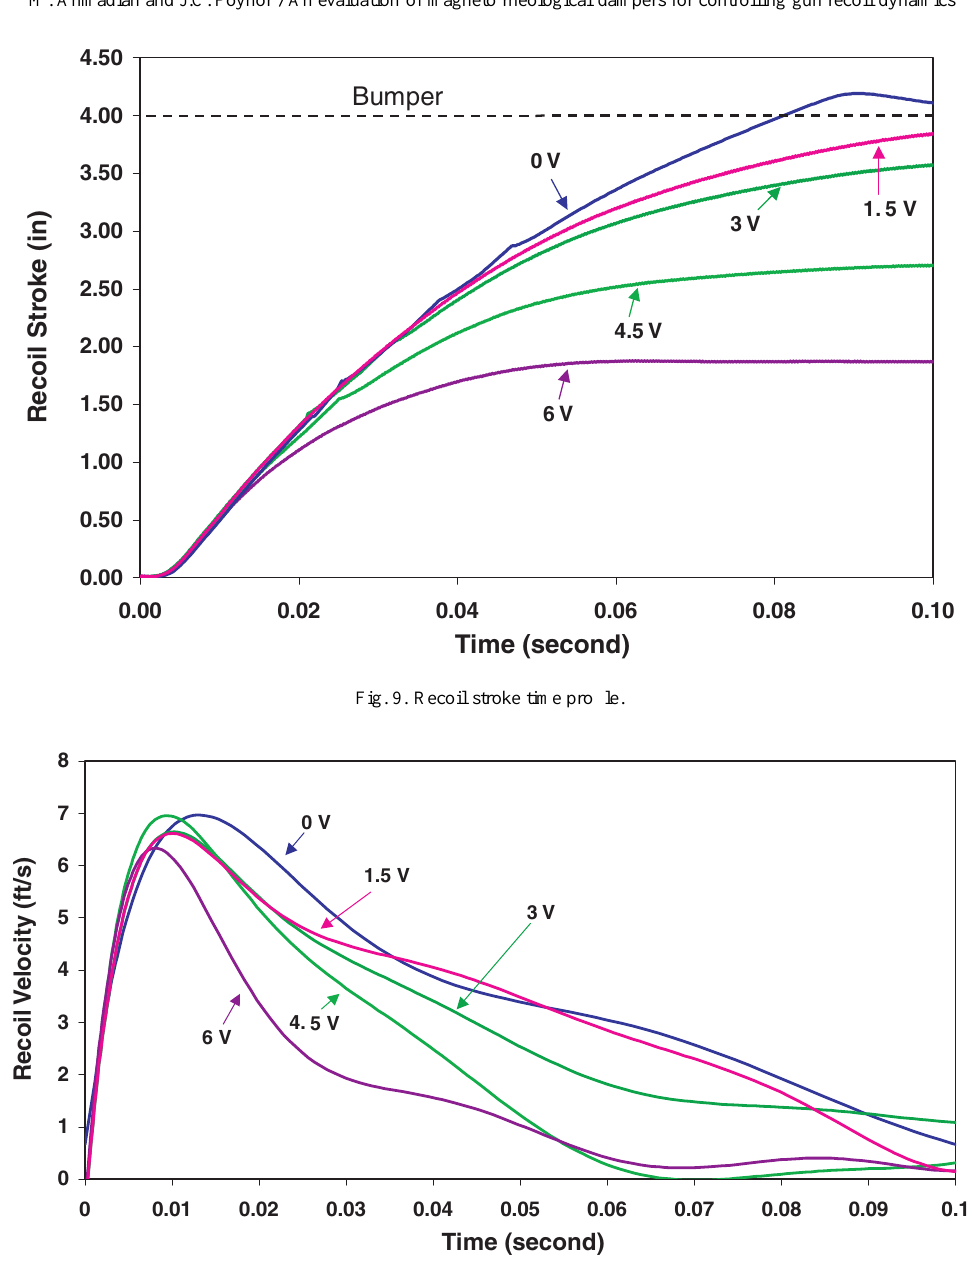
Fig. 10. Recoil velocity time